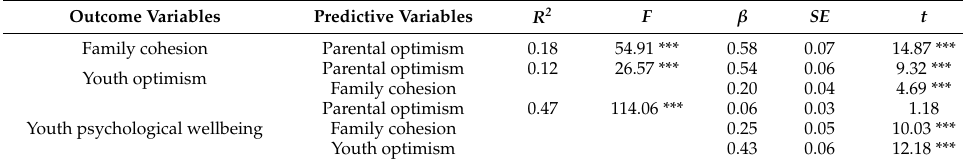
and gender as control variables, parental optimism positively predicted family cohesion ( β = 0.58, SE = 0.07, p < 0.001) as well as youth optimism ( β = 0.54, SE = 0.06, p < 0.001); family cohesion positively predicted youth optimism ( β = 0.20, SE = 0.04, p < 0.001). When parental optimism, family cohesion, and youth optimism simultaneously predicted youth Table 2. Regression analysis of the variables in the serial mediation model. PWB, both family cohesion ( β = 0.25, SE = 0.05, p < 0.001) and youth optimism ( β = 0.43, SE = 0.06, p < 0.001) turned out to be significantly positive indicators of youth PWB, while Outcome Variables parental optimism no longer significantly predicted youth PWB ( β = 0. 06, SE = 0.03, p = 0. 219). Table 2. Regression analysis of the variables in the serial mediation model. Outcome Variables